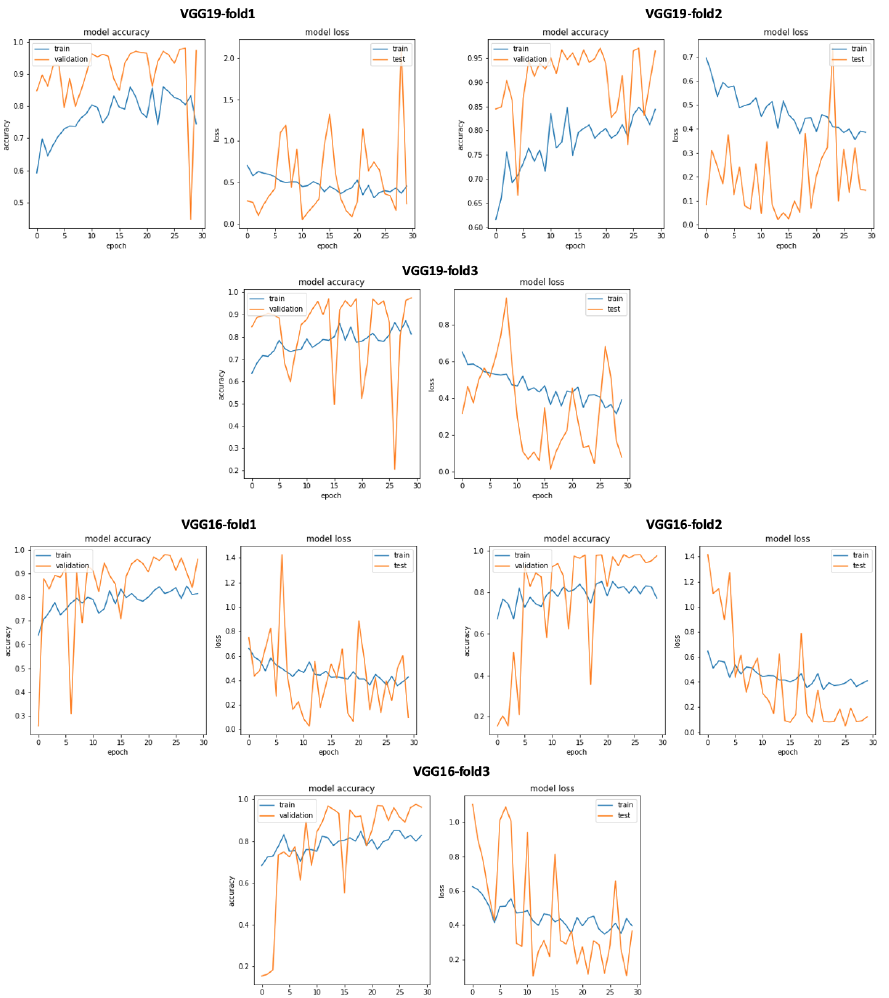
Figure 21. VGG19 and VGG16 training and validation curves using data selection based on KDE.